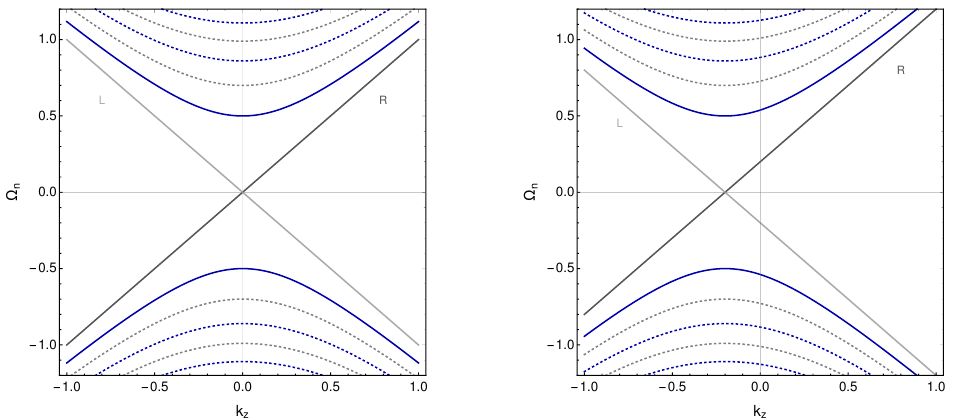
Figure 1 . Energy levels for fermions in the presence of background gauge (cid:12)elds. The solid blue lines denote the lowest Landau level n = 0 for a massive fermion, the dotted lines correspond to higher Landau levels n (cid:21) 1. The gray lines indicate the corresponding energy levels for massless fermions, for which in the lowest Landau level is asymmetric between left-handed (L) and right-handed (R) fermions. Note that all higher Landau levels (dotted curves) have a two-fold degeneracy, i.e., the dispersion relation is identical for left- and right-handed particles. For the purpose of these plots, we use units where g j Q j E = 1. In these units, we set ma = 0 : 5, 2 g j QB j = 0 : 7 and t = 0 ( t = 0 : 2) in the left (right)